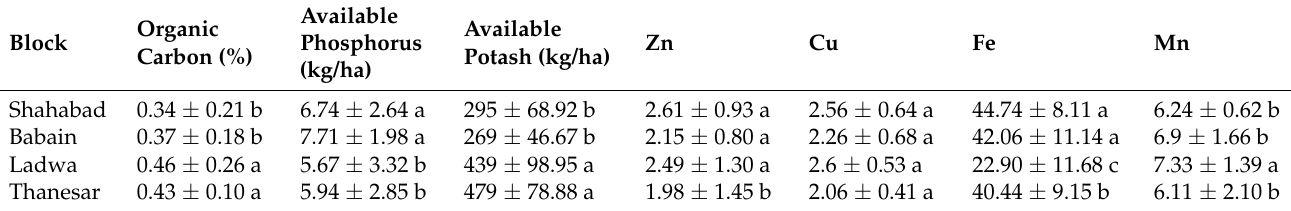
Table 1. Soil properties of the samples collected from farmer’s field in year 2019. Different letters states significant differences among different blocks for each